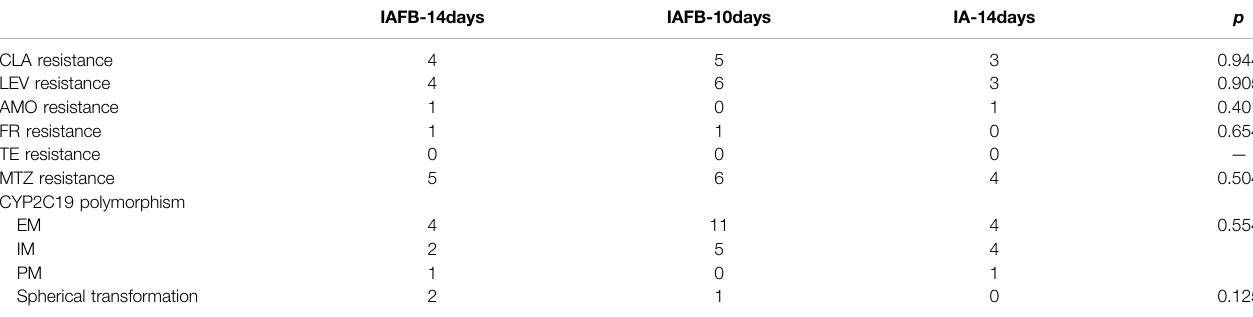
TABLE 4 | Drug sensitivity and immunohistochemistry in patients with treatment failure.